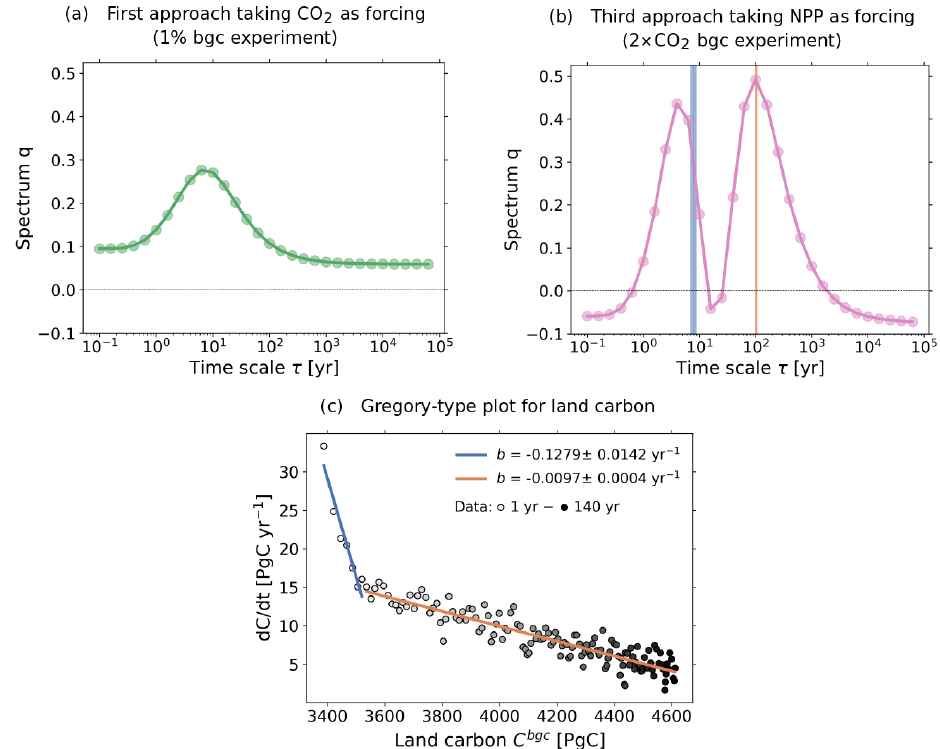
Figure 9. Spectra associated with χ NPP derived with different resolutions and a Gregory-type plot to identify the timescale structure of land carbon. (a) Spectrum derived with the first approach (taking CO 2 as forcing) from the 1% bgc experiment; (b) spectrum derived with the third approach (taking NPP as forcing) from the 2 × CO 2 bgc experiment; (c) Gregory-type plot of global land carbon against land–atmosphere carbon flux. Dots are the data, with the color scale from white to black indicating the evolution from 1 to 140 years. Values of b indicate the rate at which the time derivative of land carbon changes with respect to the land carbon itself. Ranges of timescales corresponding to each rate accounting for 1 standard deviation are shown in (b)